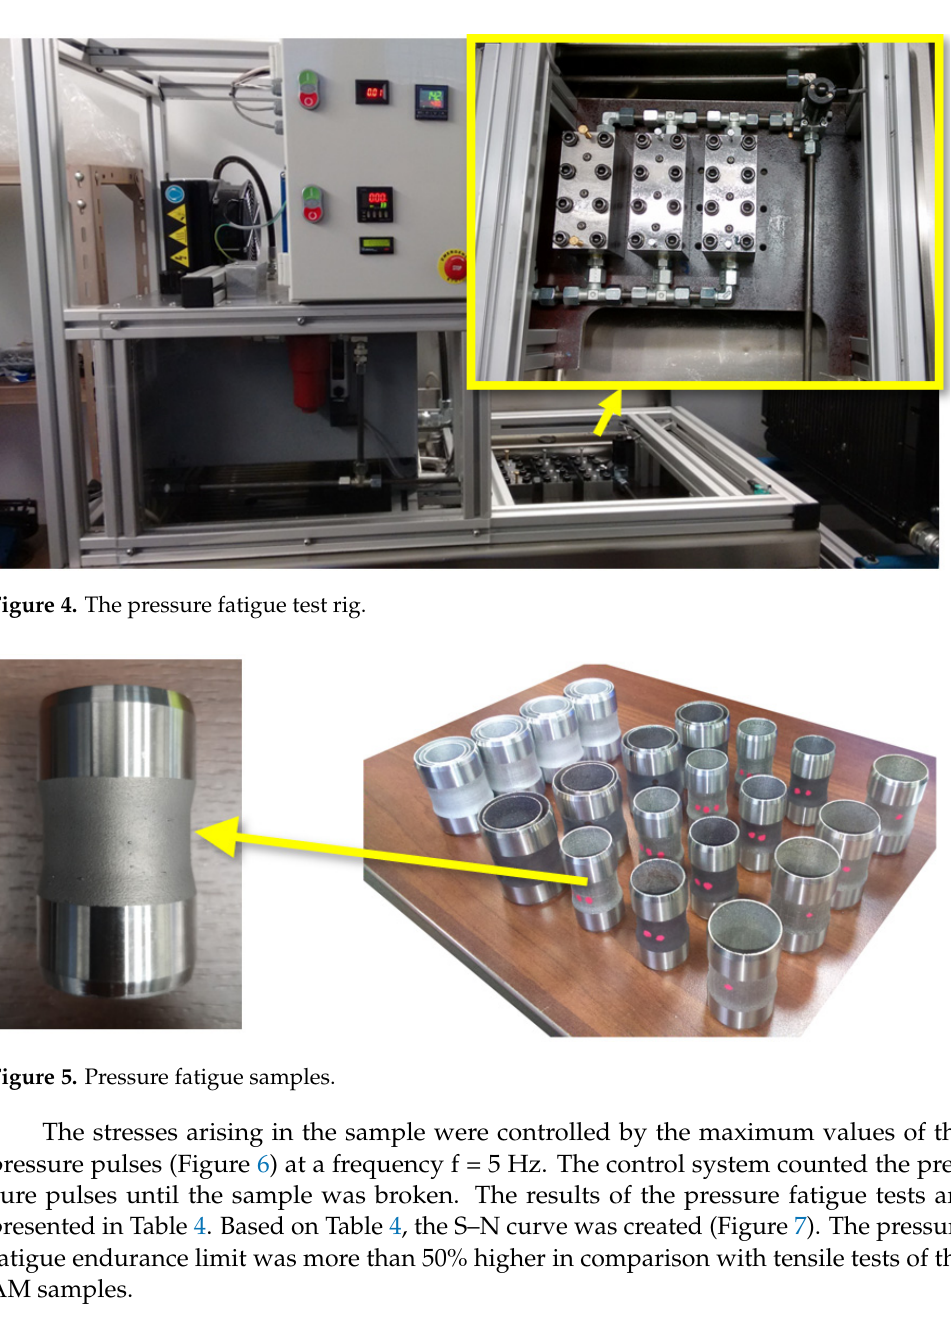
Figure 6. Pressure impulse waveform. Table 4. Pressure fatigue test results.